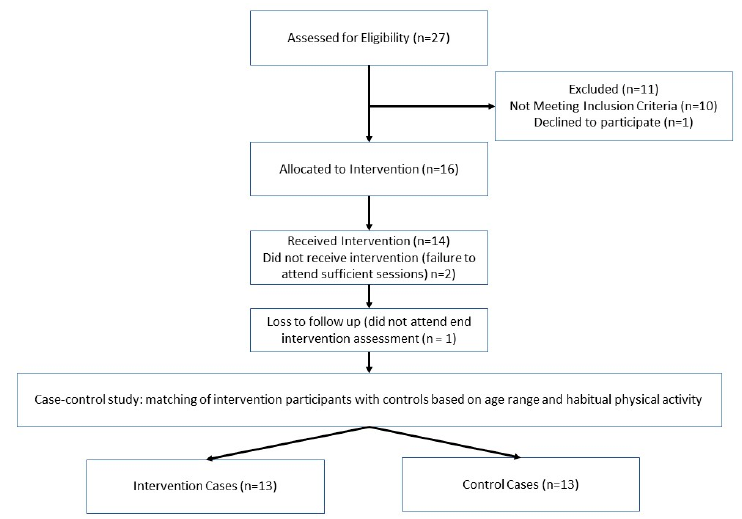
Figure 1. CONSORT flow diagram for recruitment using case–control studies .